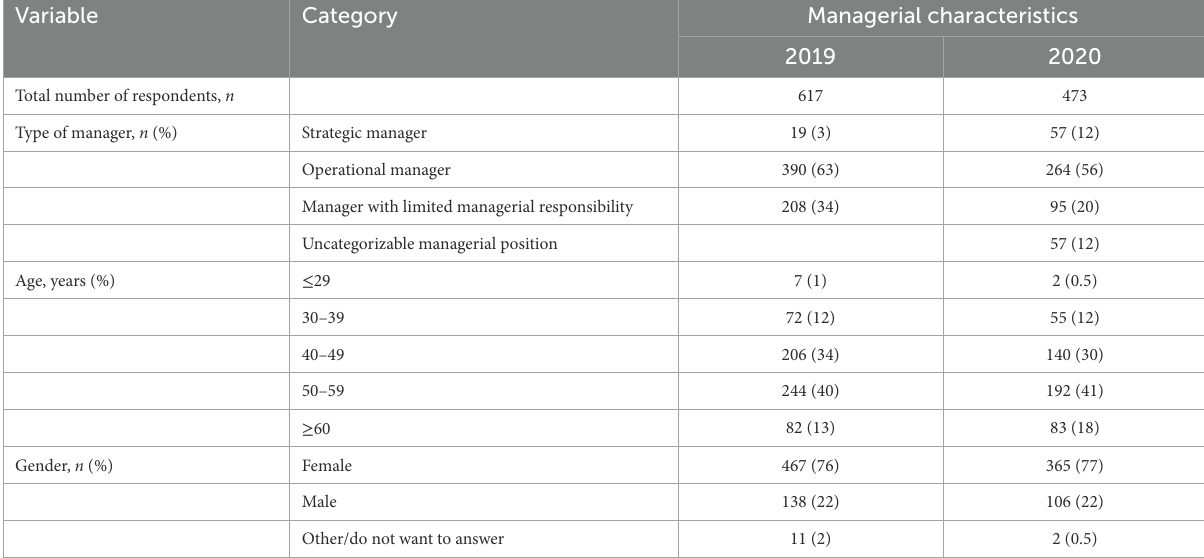
TABLE 1 Description of the managerial study group in 2019 and 2020 by managerial position, age and gender.